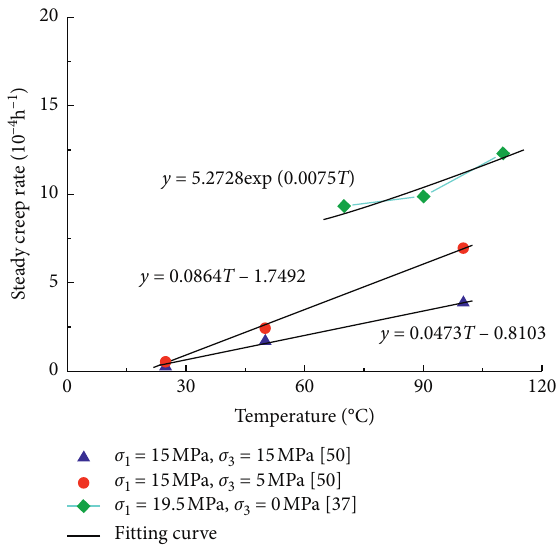
Figure 3: Relationship between temperature and steady creep rate of salt rock [37,